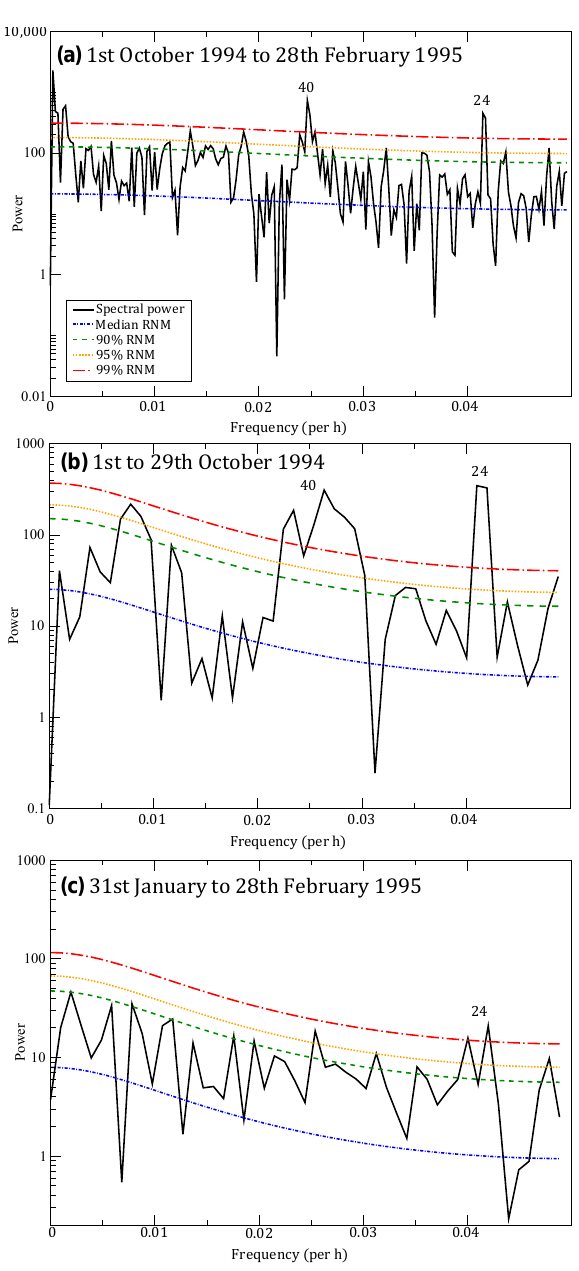
Figure 2. MTM spectra showing time-series power spectral density of the daily event counts of (a) the whole hourly event count time series (1 October 1994–28 February 1995), (b) the first 4 weeks (1–29 October 1994), and (c) the last 4 weeks of the time series (31 January–28 February 1995). The power spectral density is plot- ted against various confidence levels of the red noise model. Peaks exceeding at least the 99% confidence level are annotated with cor- responding cycle period in